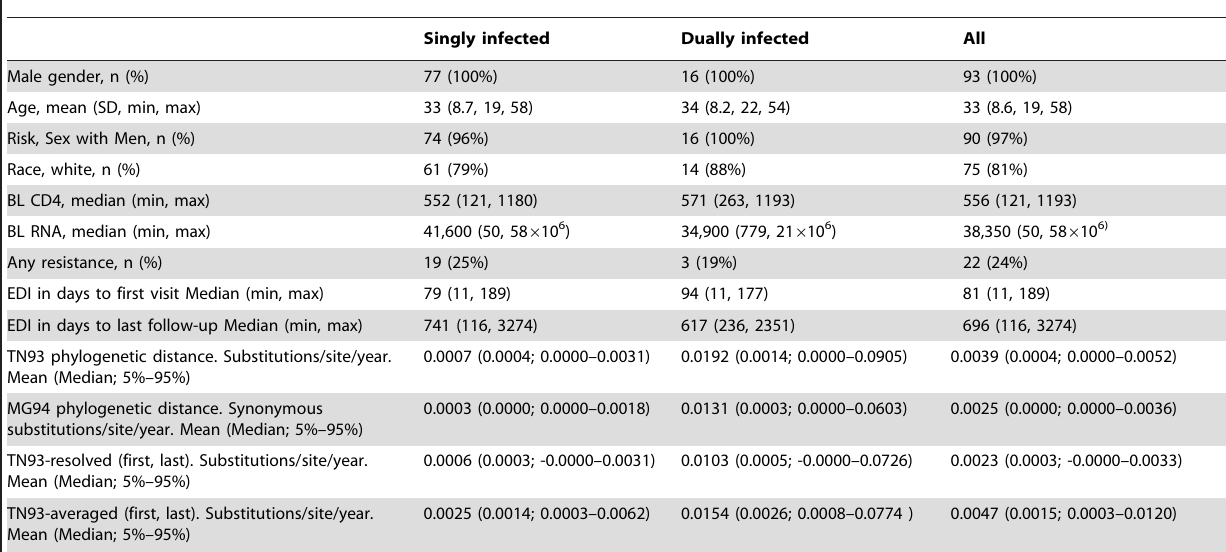
Table 1. Participant demographics and major